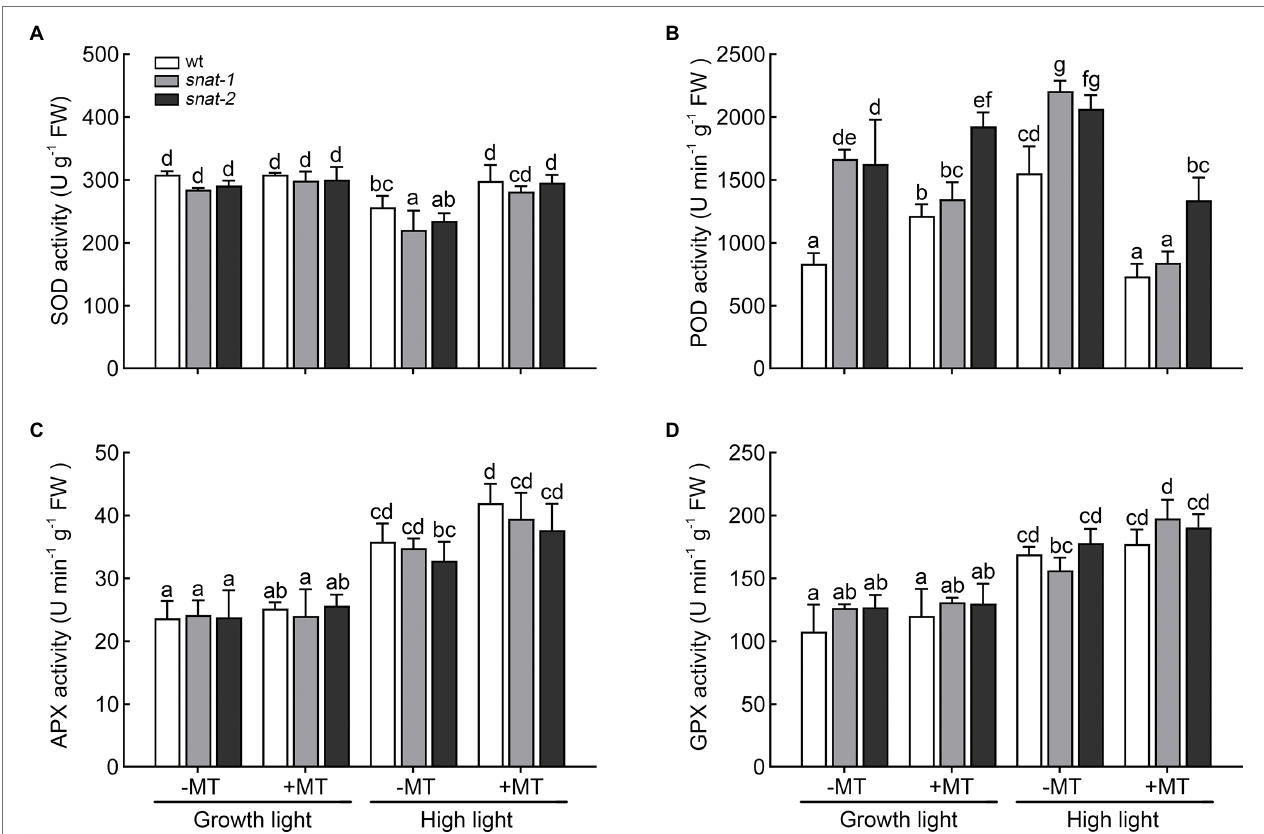
FIGURE 7 | Effects of exogenous melatonin on the activity of antioxidant enzyme. (A) Superoxide dismutase (SOD) activity. (B) Peroxidase (POD) activity. (C) Ascorbate peroxidase (APX) activity. (D) Glutathione peroxidase (GPX) activity. Others are the same as in Figure 1 .